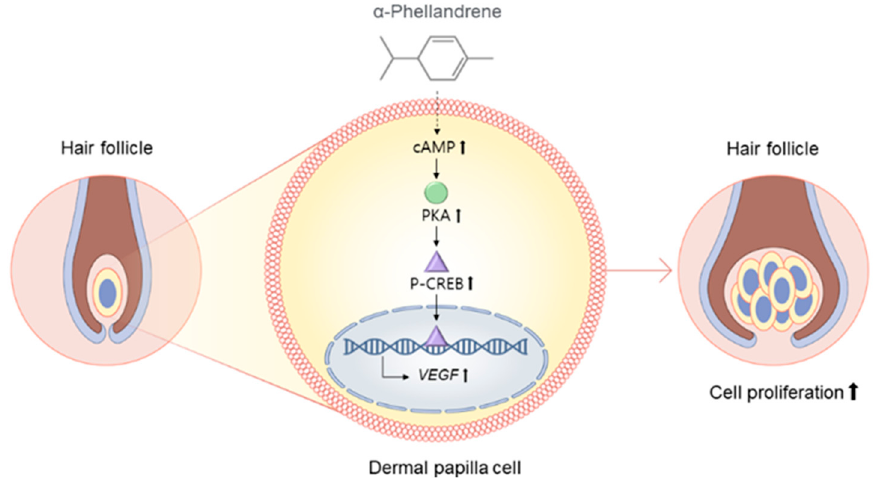
Figure 7. Schematic illustration of the molecular mechanism of α -phellandrene-mediated dermal papilla cell (DPC) proliferation. α -phellandrene activated the cyclic adenosine monophosphate (cAMP) signaling and increased vascular endothelial growth factor (VEGF) expression, thereby promoting DPC